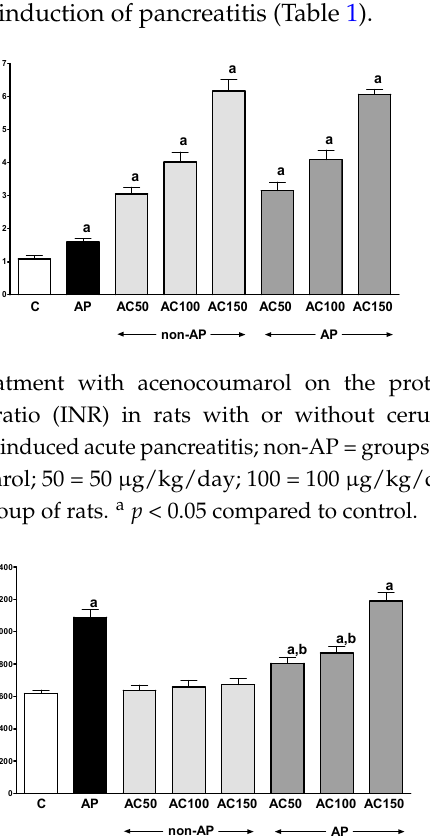
Figure 2. Impact of pretreatment with acenocoumarol on the weight of the pancreas in rats with or without cerulein-induced pancreatitis. Key: C = control; AP = cerulein-induced acute pancreatitis; non-AP = groups without induction of acute pancreatitis; AC = acenocoumarol; 50 = 50 µg/kg/day; 100 = 100 µg/kg/day; 150 = 150 µg/kg/day. Mean ± SEM. n = 10 in each group of rats. a p < 0.05 compared to control; b p < 0.05 compared to AP alone.